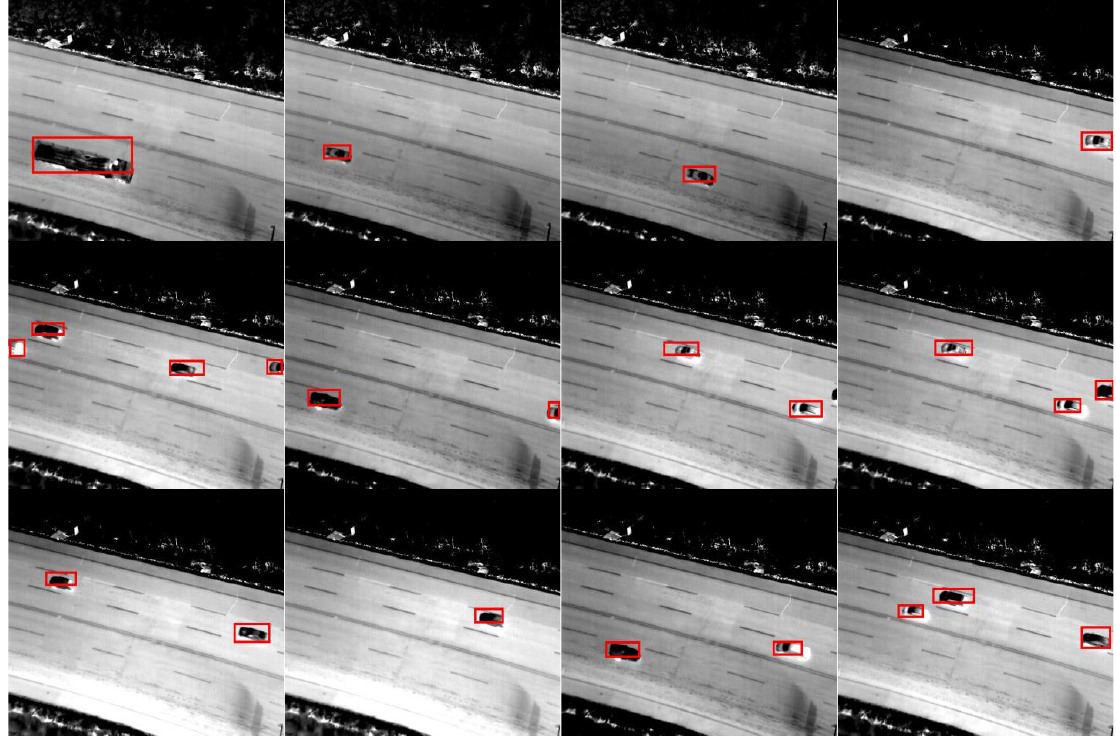
Figure 9. The performances of the method on partial images of Scenes Change